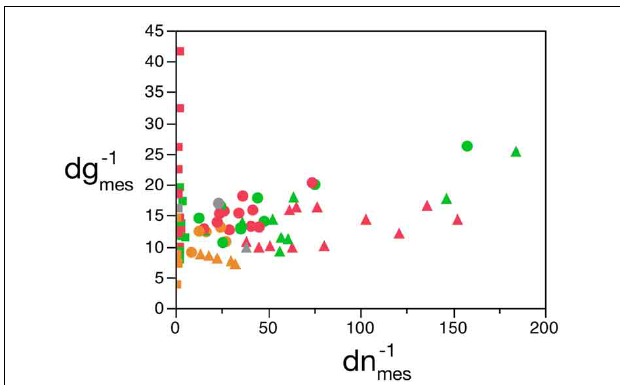
FIGURE 2 | Covariation in glial and neuronal density across brain structures and species. The inverse of neuronal (X-axis) and glial (Y-axis) cell density, expressed as picograms per cell, is plotted for each species and brain structure: cerebral cortex (circles), cerebellum (squares) and rest of brain (triangles). Data from Herculano-Houzel et al. (2006, 2007, 2011), Azevedo et al. (2009), Sarko et al. (2009), and Gabi et al.